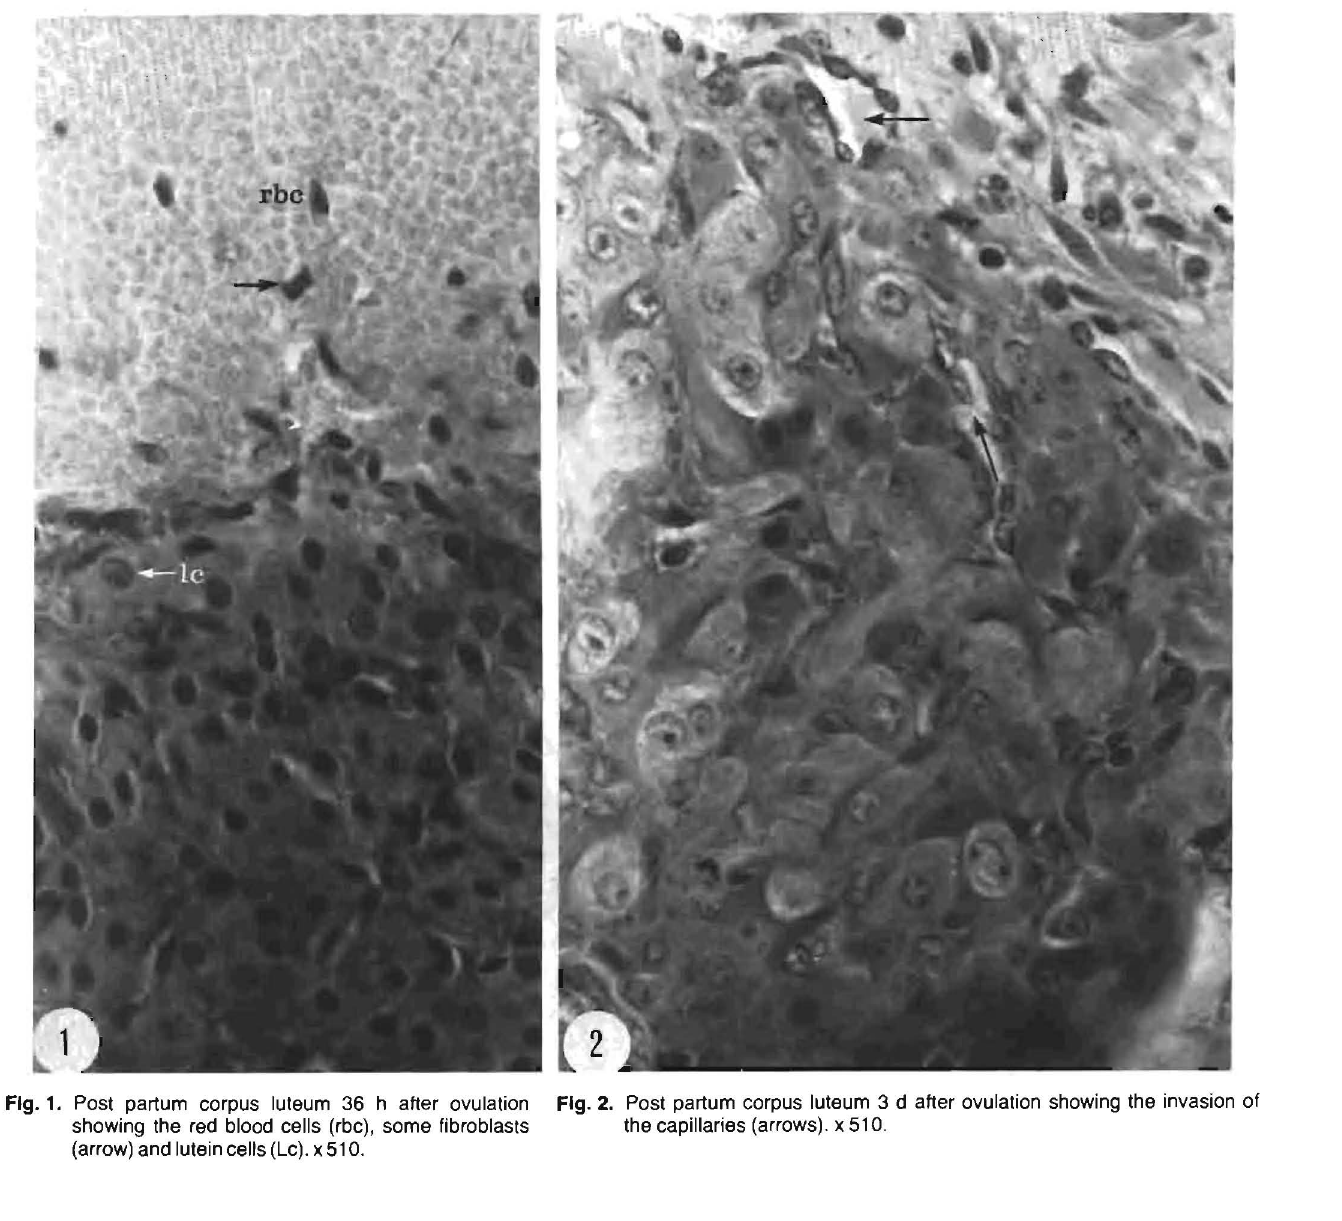
Fig. 1. Post partum corpus luteum 36 h after ovulation showing the red blood cells (rbc), some fibroblasts (arrow) and lutein cells (Lc). x 51 O.